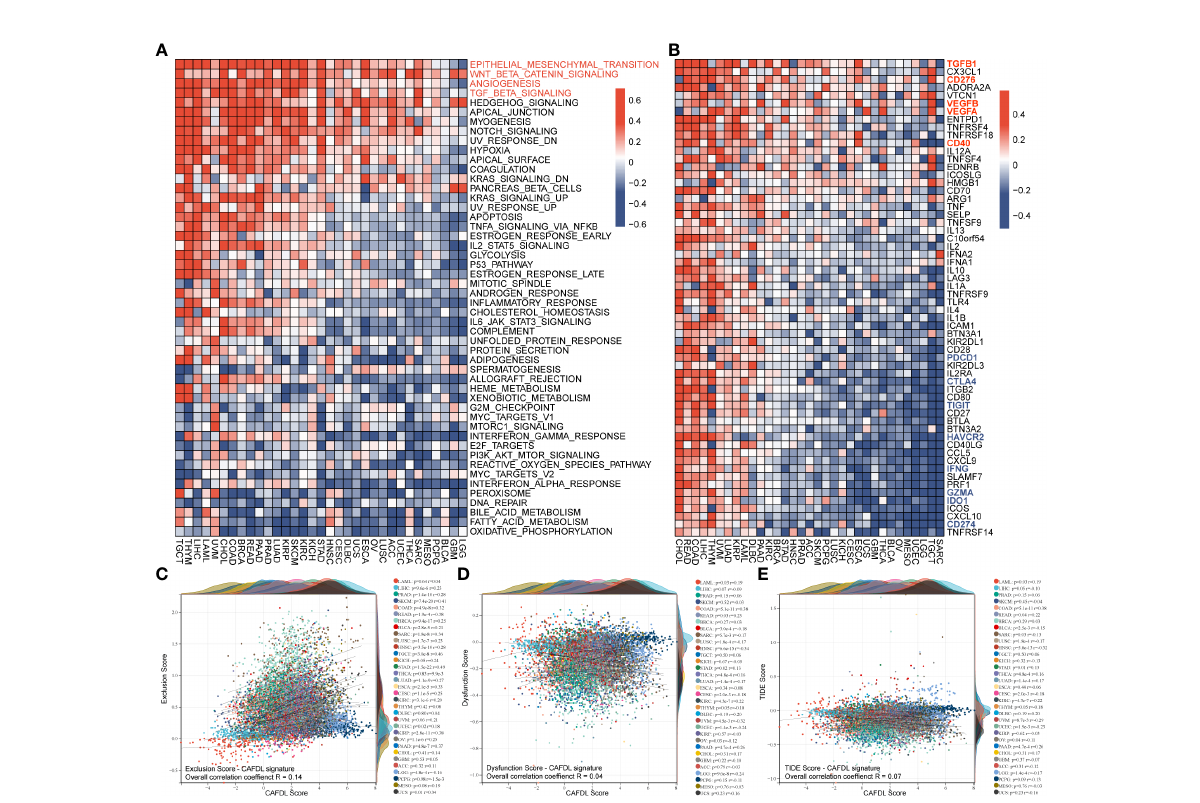
FIGURE 7 Molecular features of CAFDL signature. (A) Correlation of CAFDL signature with cancer hallmark gene sets across pan-cancer. (B) Correlation of CAFDL signature with common immune regulators across pan-cancer. (C – E) Correlation of CAFDL signature with immune exclusion score (C) , immune dysfunction score (D) , and TIDE score (E) across